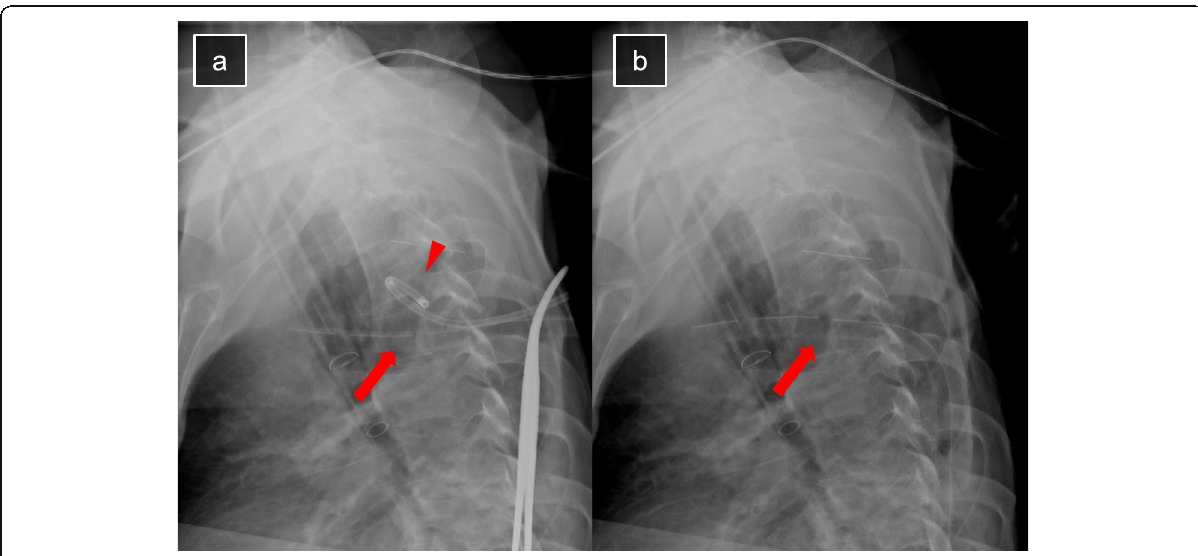
Fig. 2 Catheter exchange procedure. a The 10-Fr pigtail catheter (arrowhead) is used as a guide for accessing the abscess cavity. b Exchange with a larger size (28 Fr) catheter